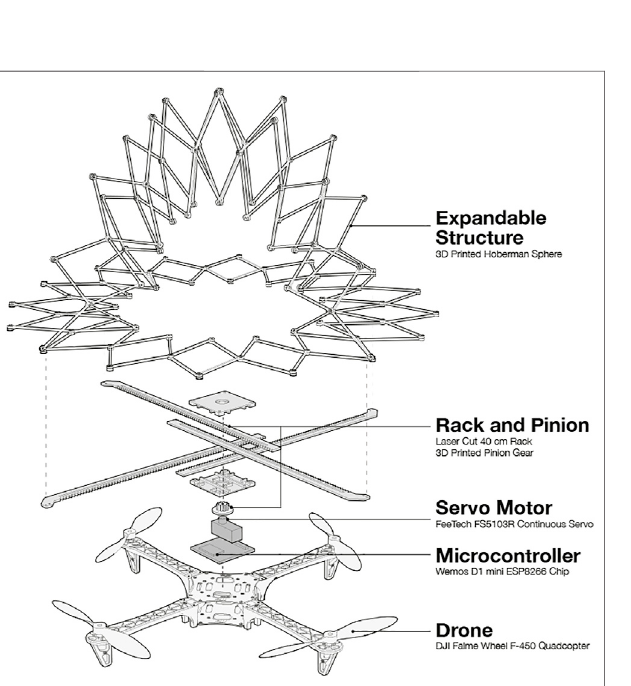
Frontiers in Robotics and AI |